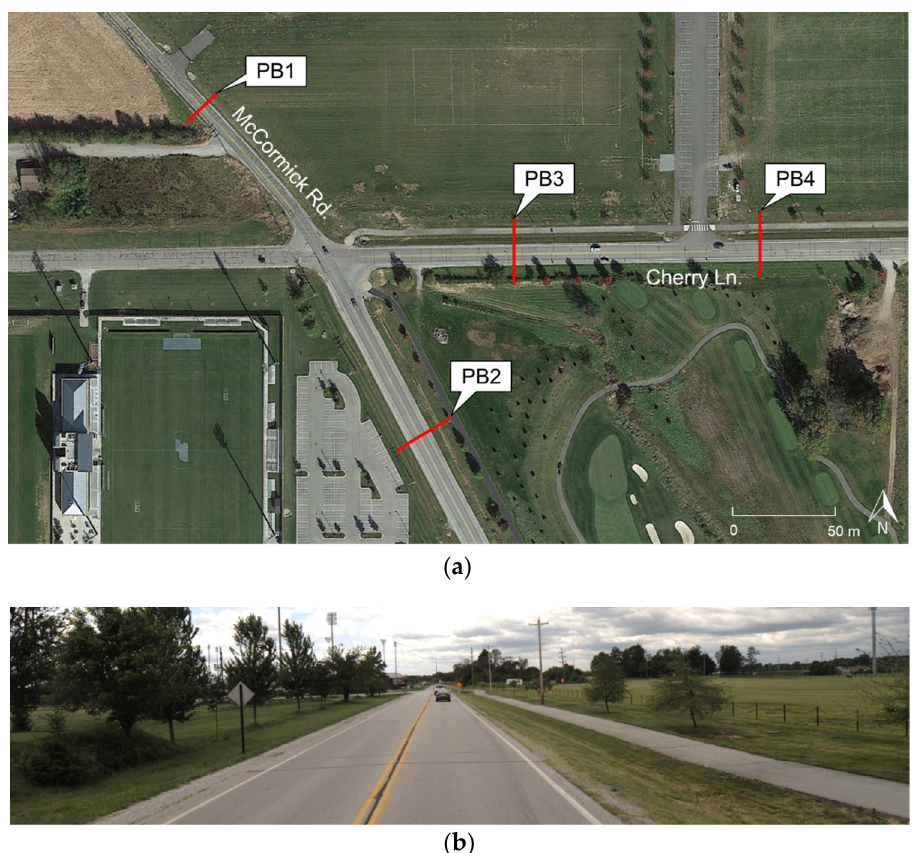
Figure 3. Study site at McCormick Rd: ( a ) surveyed area and cross-section locations PB1 , PB2 , PB3 , and PB4 (aerial photo adapted from a Google Earth image), and ( b ) image of the surveyed area at location PB3 captured by one of the cameras onboard the PWMMS-HA.